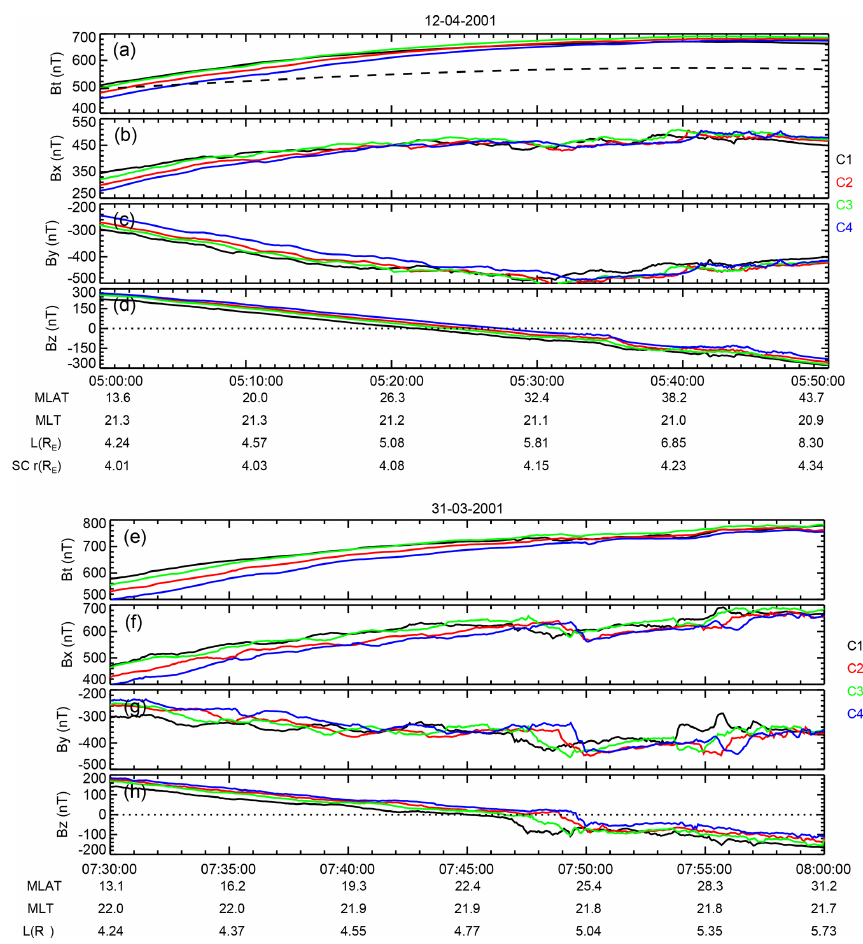
Figure 4. Magnetic field observed by the four Cluster satellites during 12 April 2001 and 31 March 2001 storm